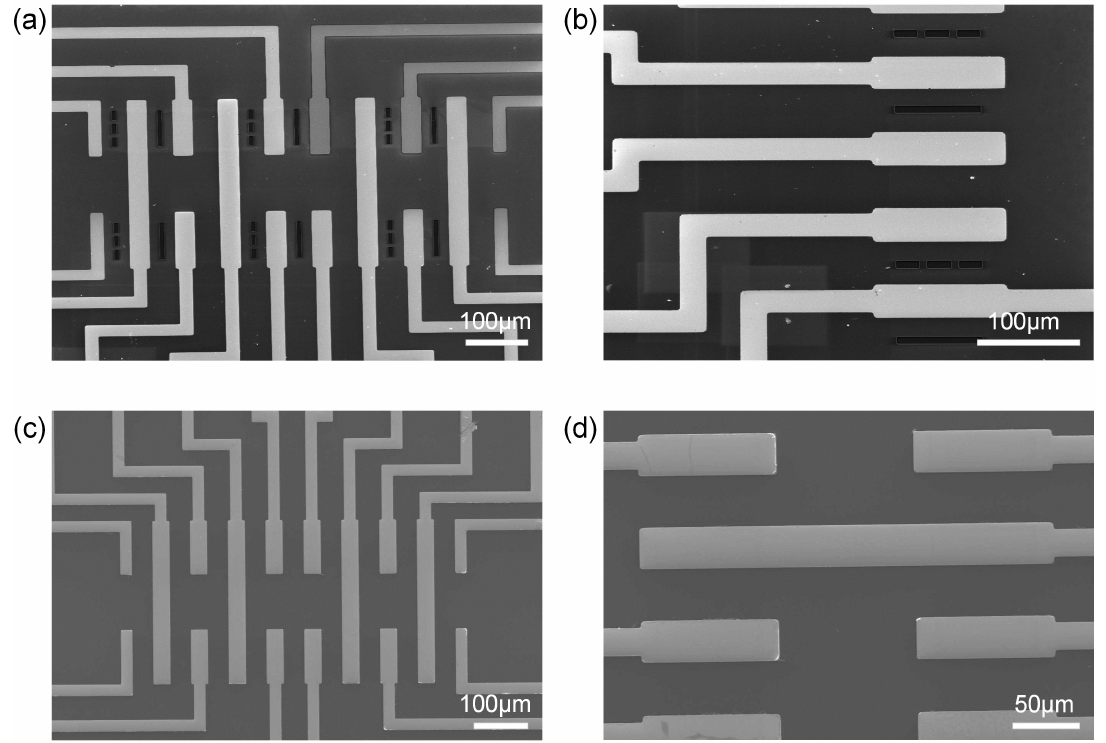
Figure 2. SEM images of the sensors: ( a ) Local diagram of the cavity-type graphene sensor chip; ( b ) Enlarged image of the bottom devices shown in ( a ); ( c ) Local diagram of a non-cavity-type graphene sensor chip; ( d ) Enlarged image of the bottom devices shown in ( c ).